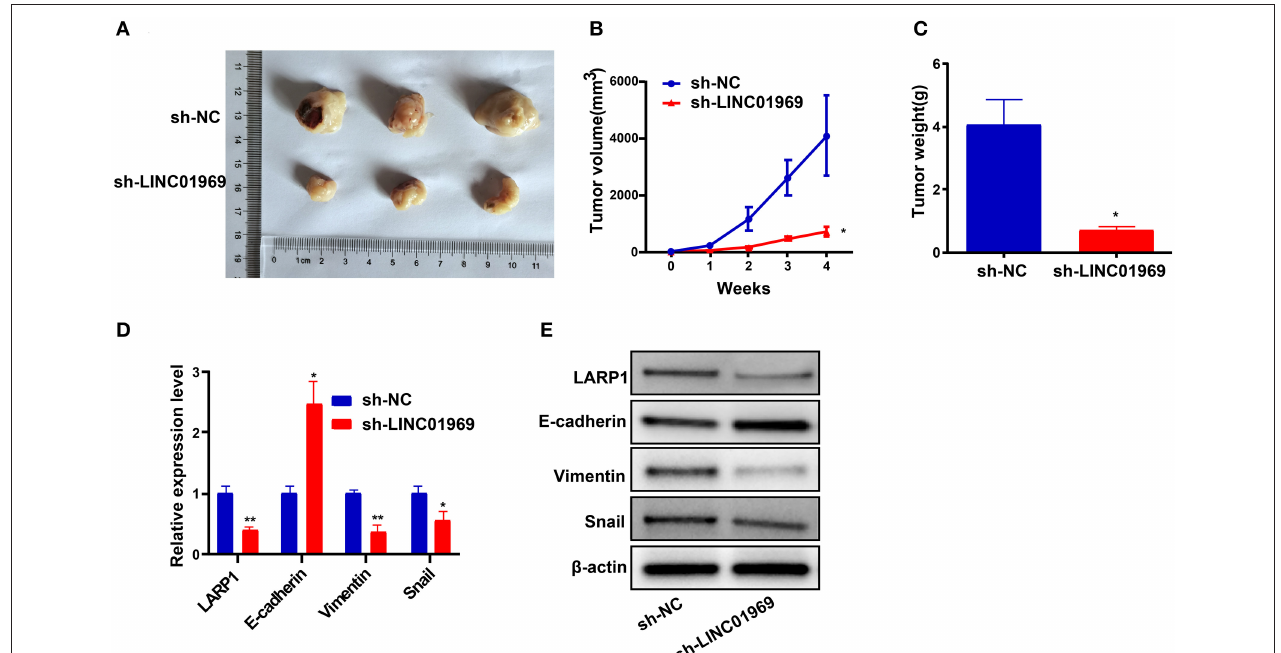
FIGURE 8 | LINC01969 short hairpin RNA (shRNA) curbs ovarian cancer (OC) cells to proliferate and metastasize in vivo . (A) Representative images of tumors from indicated orthotopic xenografts. (B) Tumor volume and (C) weight data of indicated orthotopic xenografts. (D,E) Messenger RNA (mRNA) and protein expression levels of LARP1 and epithelial–mesenchymal transition (EMT)-related markers after LINC01969 knockdown. Data were presented as mean ± SD; * P < 0.05, ** P < 0.01.